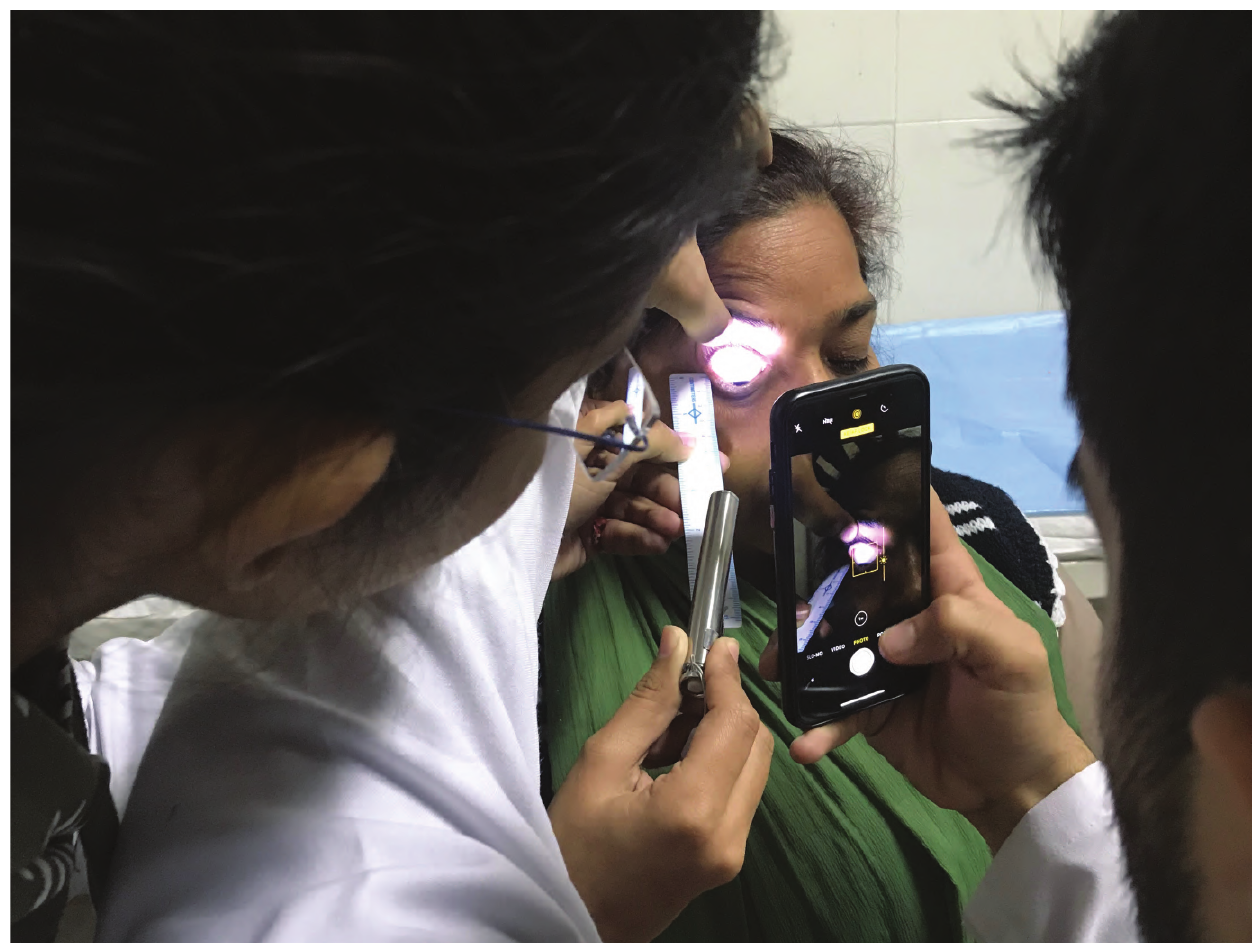
Figure 1. Bleb image being captured using smartphone.